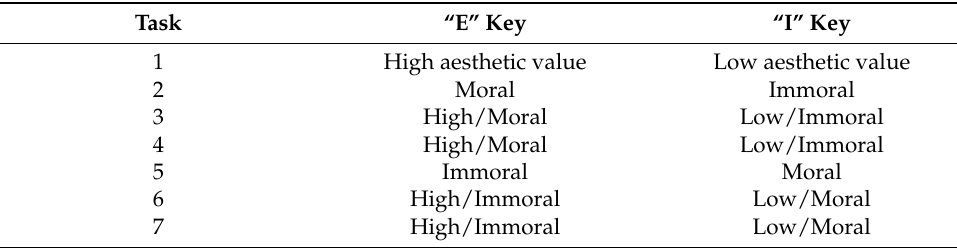
Table 3. The meaning of “E” and “I” in every task.